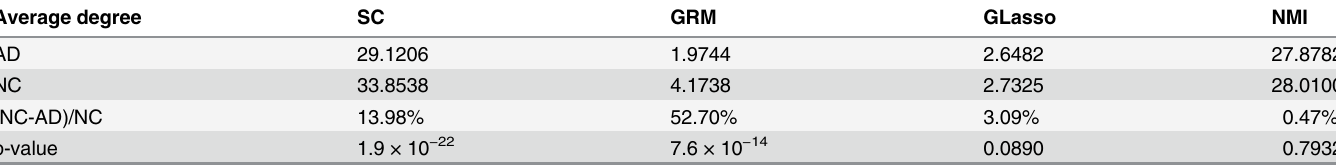
Table 5. Average degree of the weighted networks learned by different